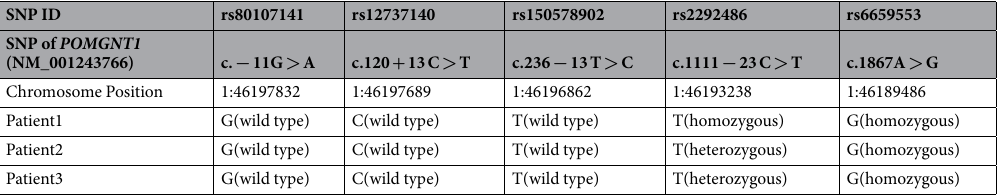
Table 3. The results of haplotype